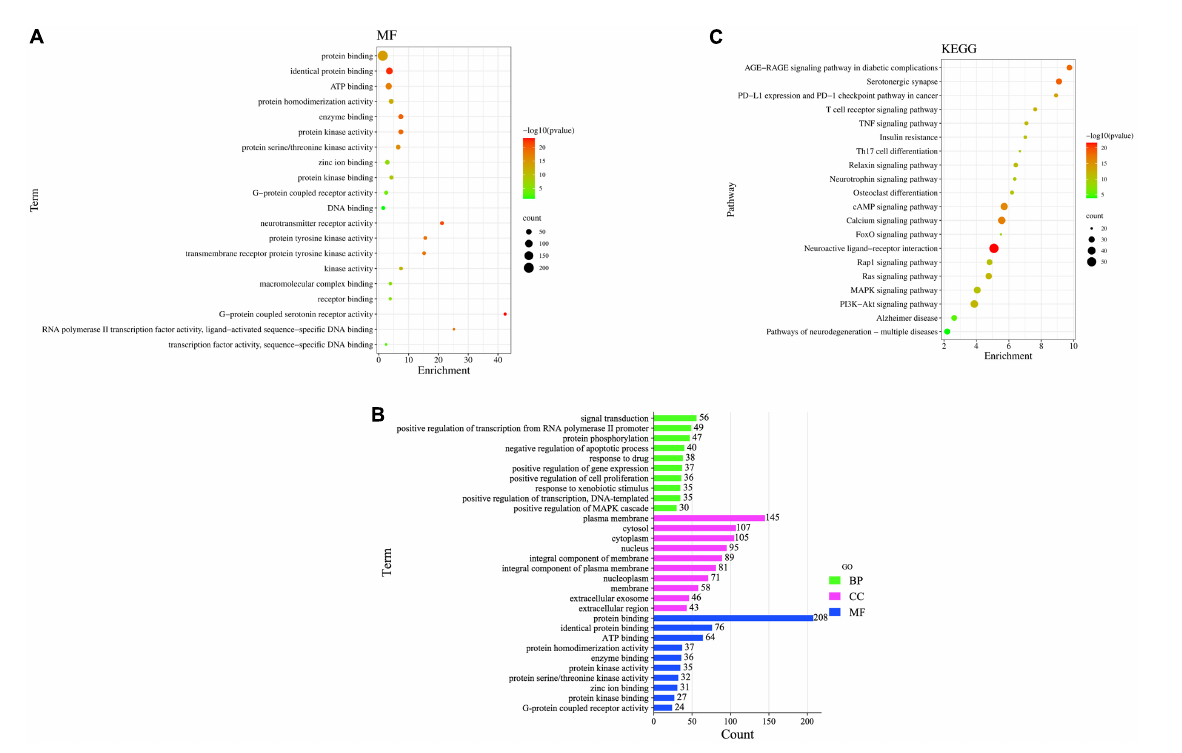
FIGURE9 (A) MF enrichment bubble diagram, (B) GO enrichment bar graph, (C) KEGG pathway enrichment analysis.